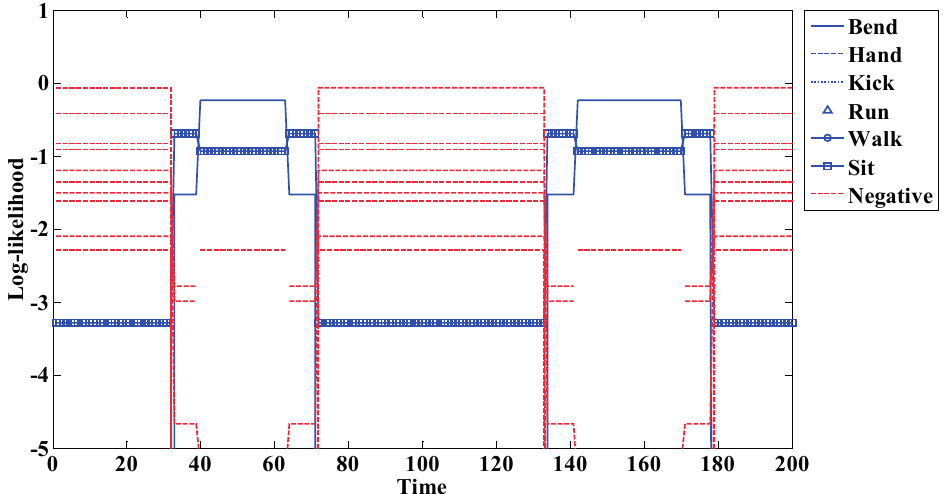
Figure 10. Example of action recognition without the spotting